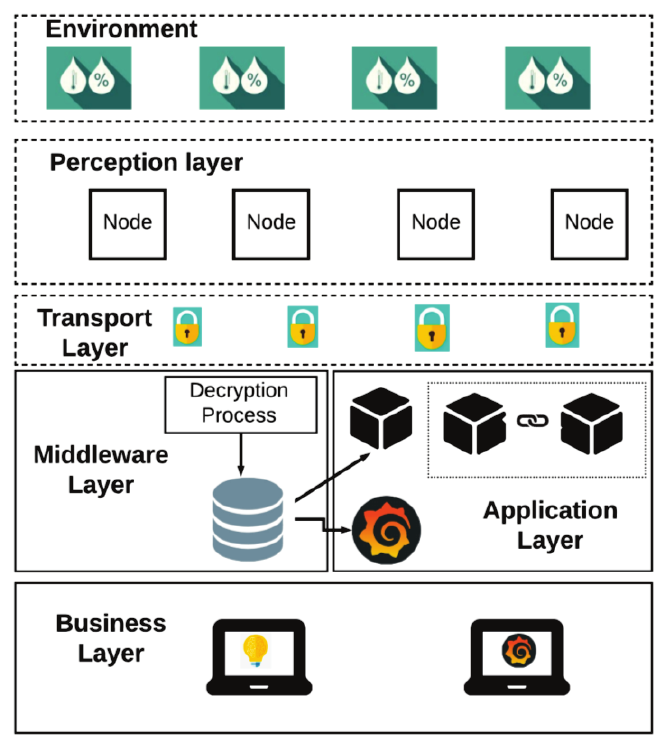
Figure 4. Architecture system scheme of Wireless Sensor Networks (WSN) together with the blockchain mechanism and symmetric encryption.